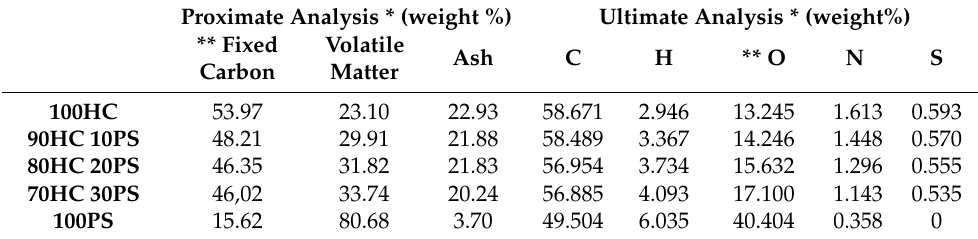
Table 2. Chemical properties of coal, pine sawdust, and fuel blends. Proximate Analysis * (weight %) Ultimate Analysis * (weight%) **